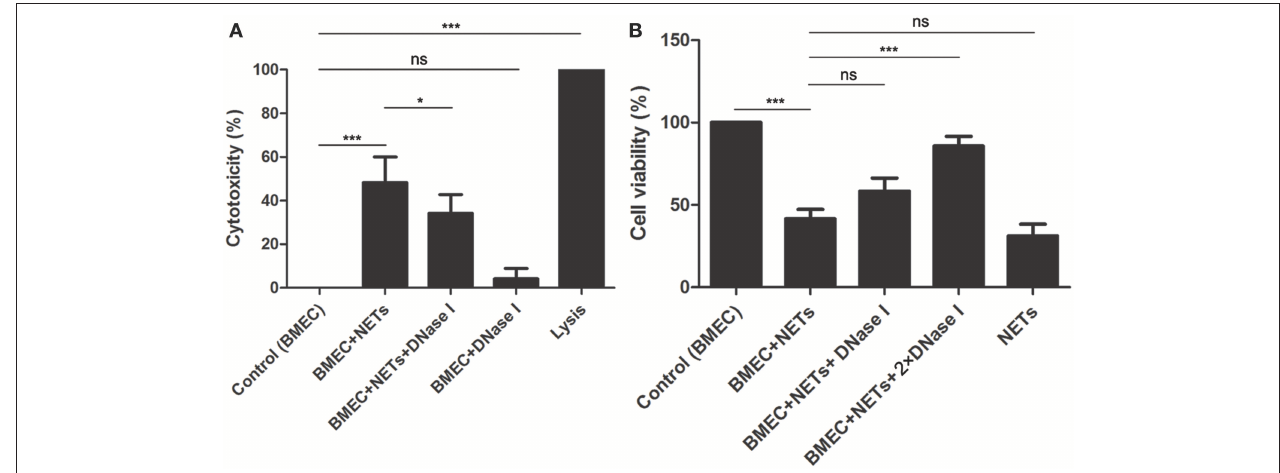
FIGURE 2 | NETs induced cytotoxicity in BMECs. (A) The cytotoxicity of BMECs was determined after treatment with NET (484ng/mL), NET (484ng/mL) + DNase I or DNase I for 16h. Lysis provided by LDH Cytotoxicity Assay Kits was used as positive controls. (B) The viability of BMECs was detected by Cell Counting Kit-8. Briefly, BMECs were treated with NET (342ng/mL), NET (342ng/mL) + DNase I (1.5 mg/mL), NET (342ng/mL) + DNase I (3 mg/mL), or NET (342ng/mL) for 16h. After washed for three times, the samples were treated with 10 µ L CCK-8, incubated for 2h and examined microplate reader at wavelength at 450nm. Date are presented as mean ± SEM ( n = 5). P < 0.05 were considered significant (* P < 0.05, *** P < 0.001, and “ns” means not significant).